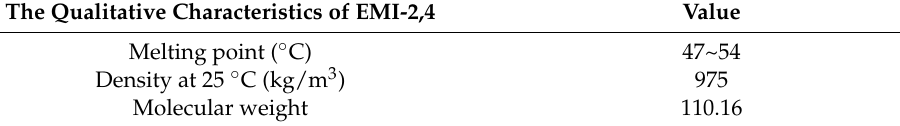
Table 3. Properties of